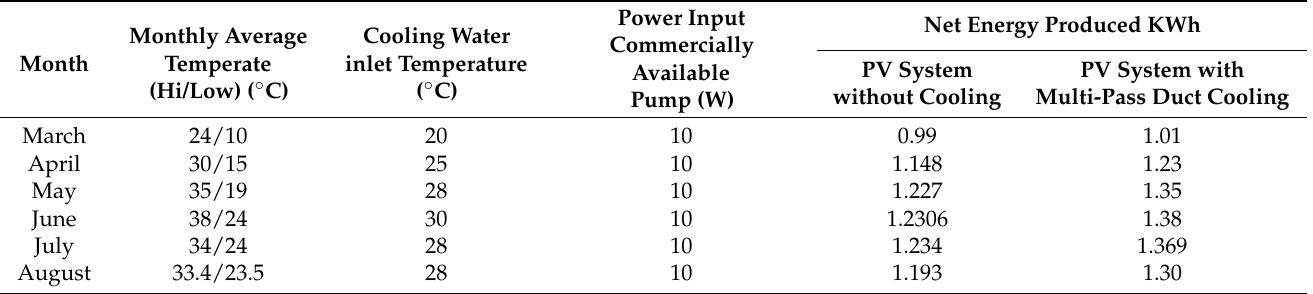
Table 5. Comparison of net energy production of PV and PV/T modules with a multi-pass duct